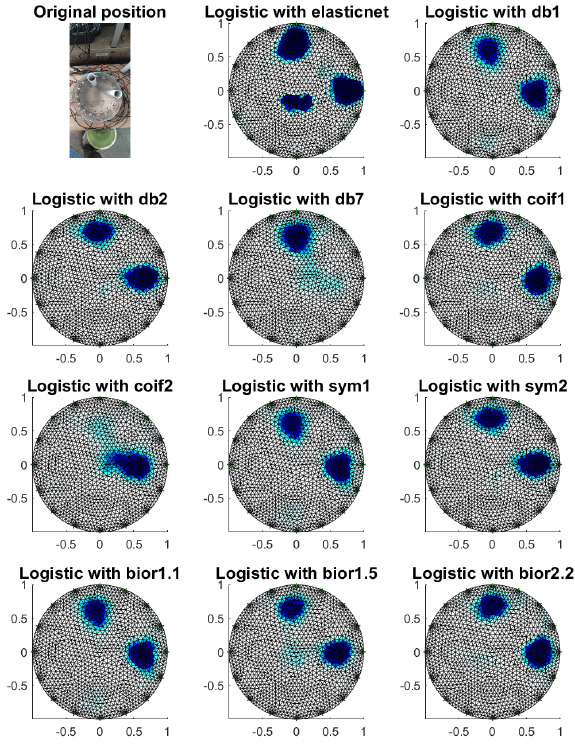
Figure 17. Image reconstruction with phantoms at electrodes 1 and 5.